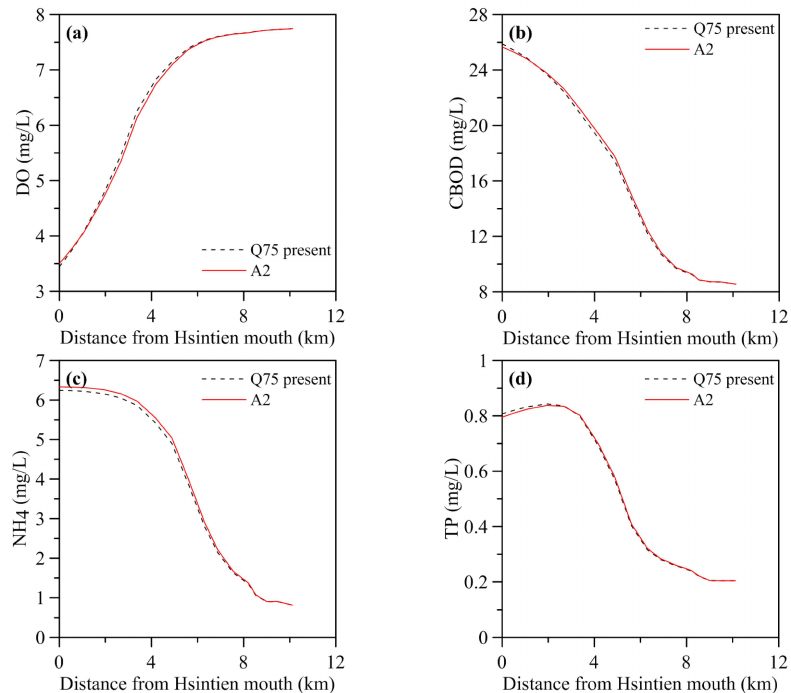
Figure 9. Predicting water quality distributions for present and climate change (A2 scenario) conditions under Q75 low flow along the Hsintien Stream ( a ) DO; ( b ) CBOD; ( c ) NH4; and ( d ) TP.